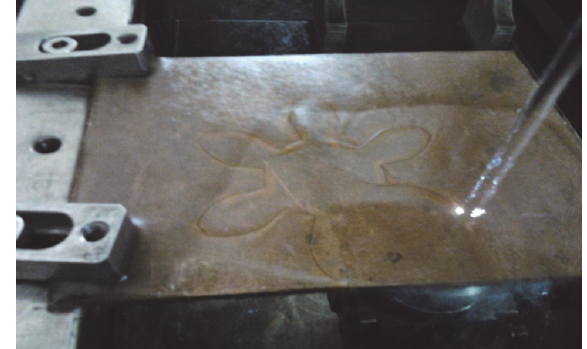
Fig. 1. A gear cut shaped copper plate using Wire